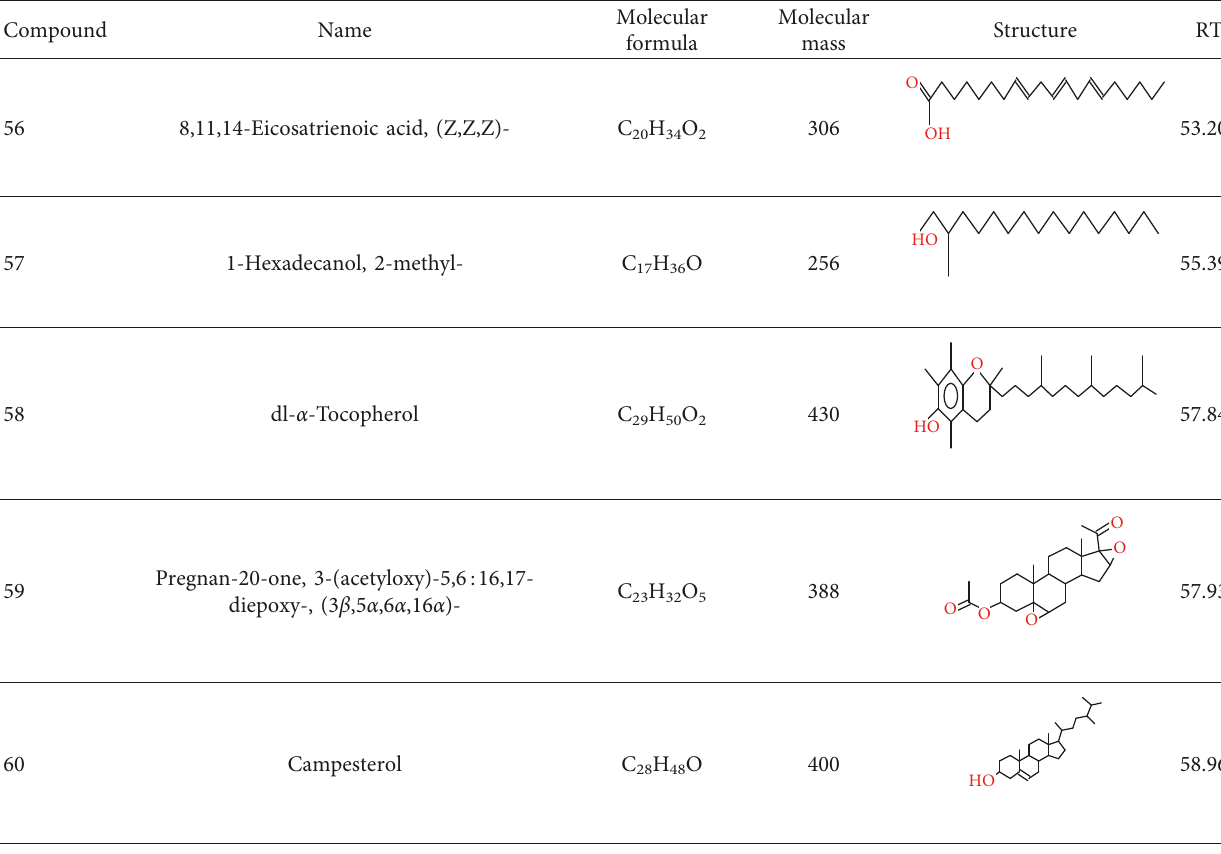
Table 13: Molecular formula, molecular mass, structure, and RT of compounds 56–60 of whole plant n -hexane fraction of Achillea wilhelmsii (WHFAW).